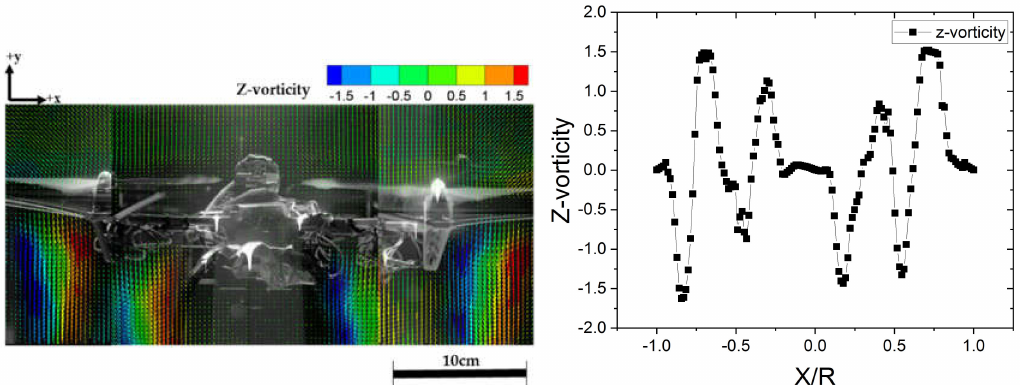
Figure 6. Vertical vorticity distribution around the drone ( Left ) visualization and ( Right ) magnitude